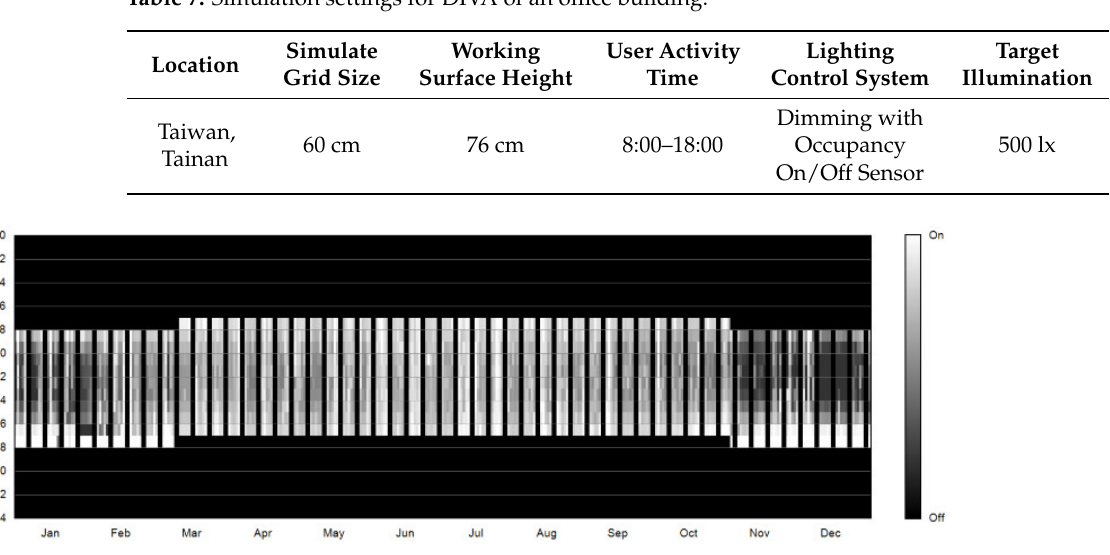
Table 7. Simulation settings for DIVA of an office building.